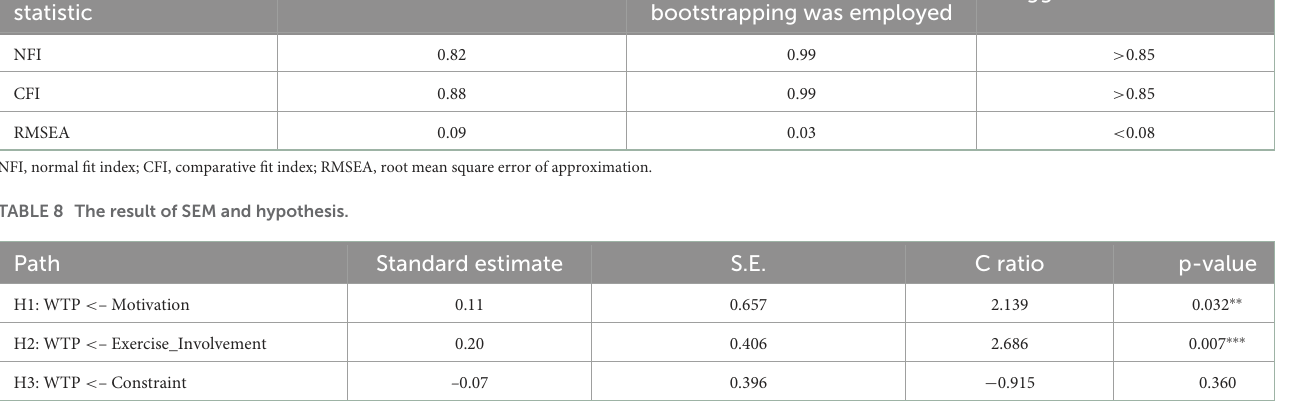
TABLE 7 Suggested goodness-of-fit statistics and acceptable cutoff criteria. Goodness-of-fit statistic